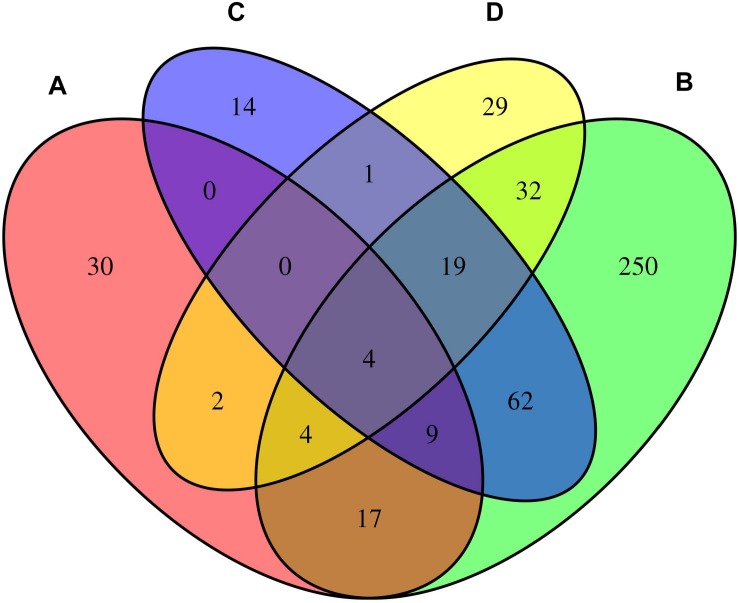
Venn diagram of the pleiotropic genes identified by metaCCA (A) and the combined genes identified by MAGMA and/or MetaXcan for asthma (B), hay fever (C) and eczema (D).